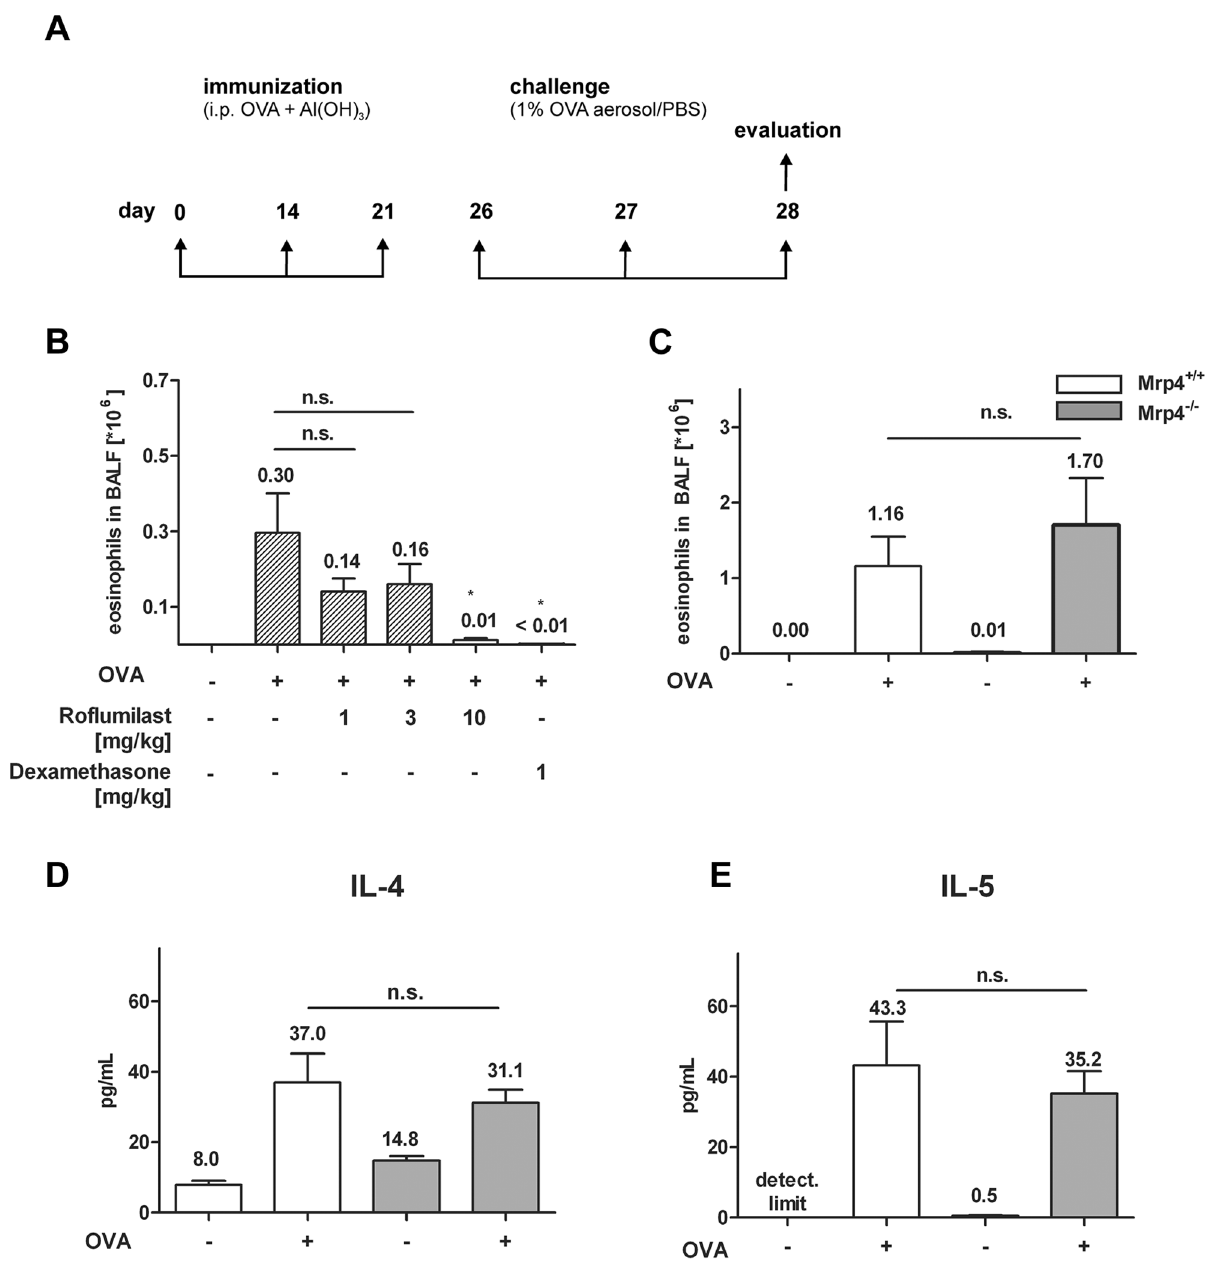
Figure 2. Eosinophil numbers were similar in BALF of OVA-sensitized Mrp4 2 / 2 and Mrp4 + / + mice after OVA-challenge. A) Schematic of the used protocol to induce Th2 mediated lung inflammation. Mice were sensitized by intraperitoneal injections of OVA and the adjuvant Al(OH) 3 at days 0, 14 and 21. At day 26 and 27 mice were challenged with aerosolized OVA ( + ) or PBS for control ( 2 ) and BALF was collected 1 day after last challenge. B) Eosinophil numbers in the BALF of wt mice after the oral application of the indicated doses of Roflumilast or Dexamethasone (1, 3 or 10 mg/kg) in comparison to PBS treated mice ( 2 ) for control. C) Eosinophil numbers or D) IL-4 and E) IL-5 concentrations in the BALF were measured in OVA-sensitized Mrp4 + / + (white bars) or Mrp4 2 / 2 mice (grey bars) after OVA-challenge ( + ) or PBS control ( 2 ). n=7–8. n.s.=not significant. Data